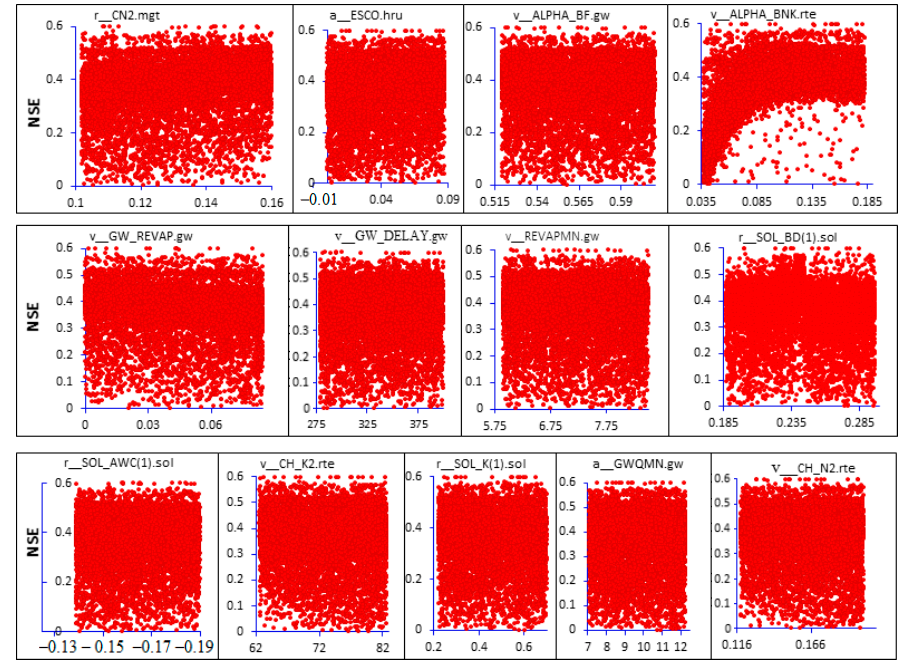
Figure 6 . Dot plot of NSE coefficient against each aggregate SWAT parameters conditioning with ParaSol based on 12,000 monthly calibration streamflow simulations.